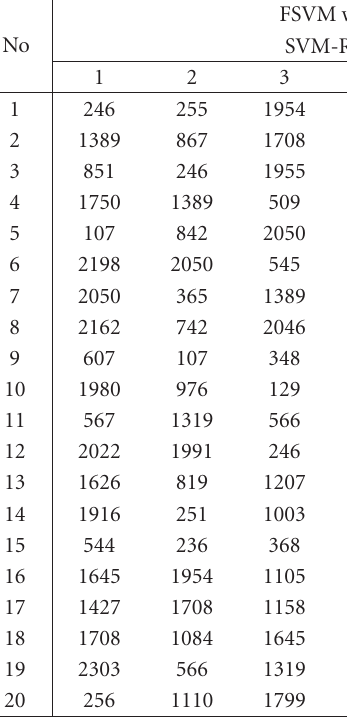
Table 4. The index no of the strongest genes selected in small round blue-cell tumors